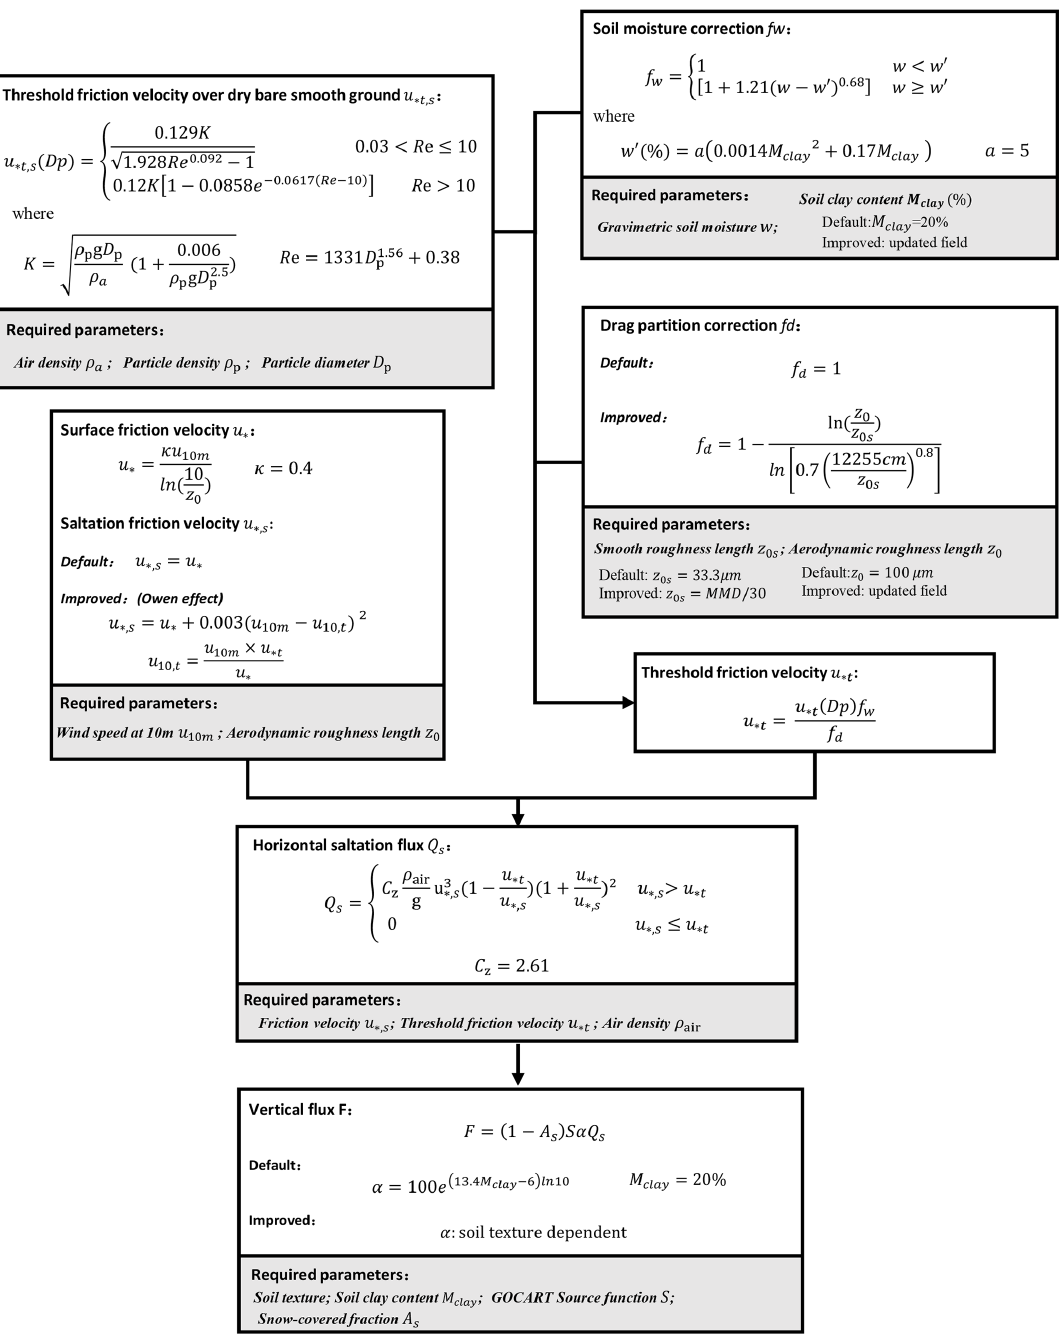
Figure 1. Schematic diagram and required input parameters in the dust emission scheme in GEOS-Chem.